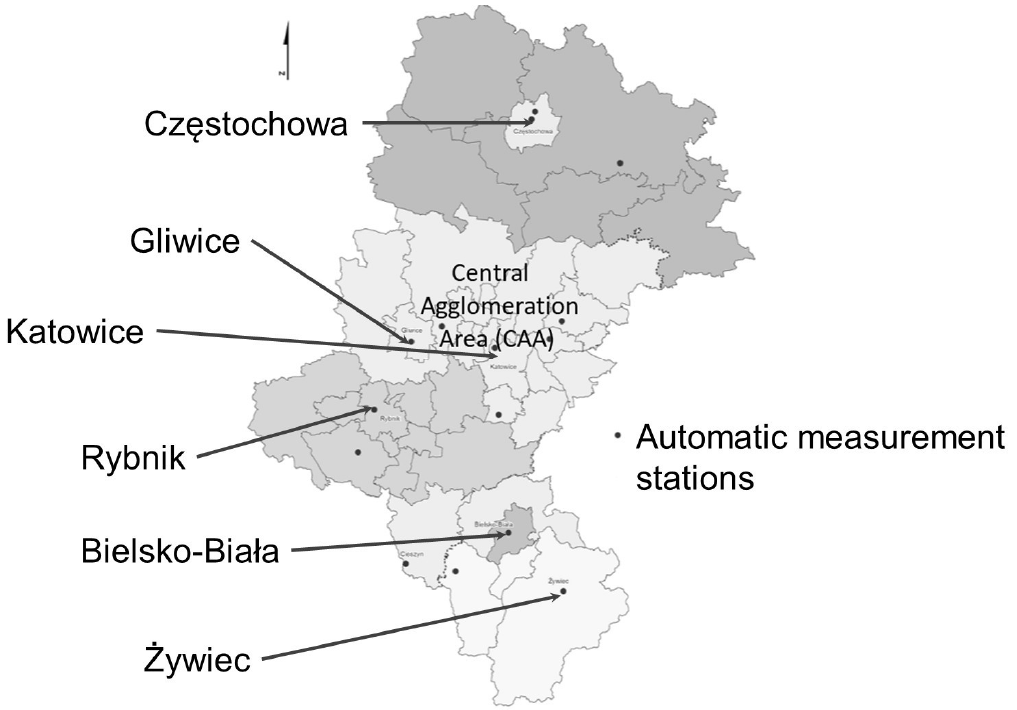
Figure 1. Map of the study region—Central Agglomeration Area (CAA); data according to the Regional Inspectorate for Environmental Protection in Katowice were available at the previous prognosis system’s website: http://spjp.katowice.wios.gov.pl/strefy2.html (cited 1 December 2018).